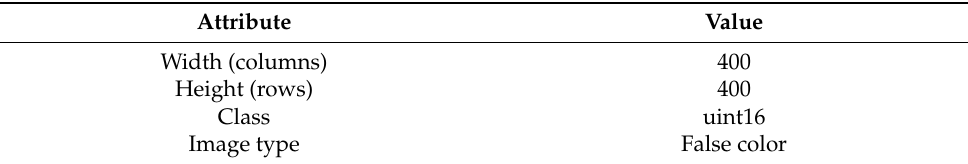
Table 3. Image details/information of all thermal solar cell